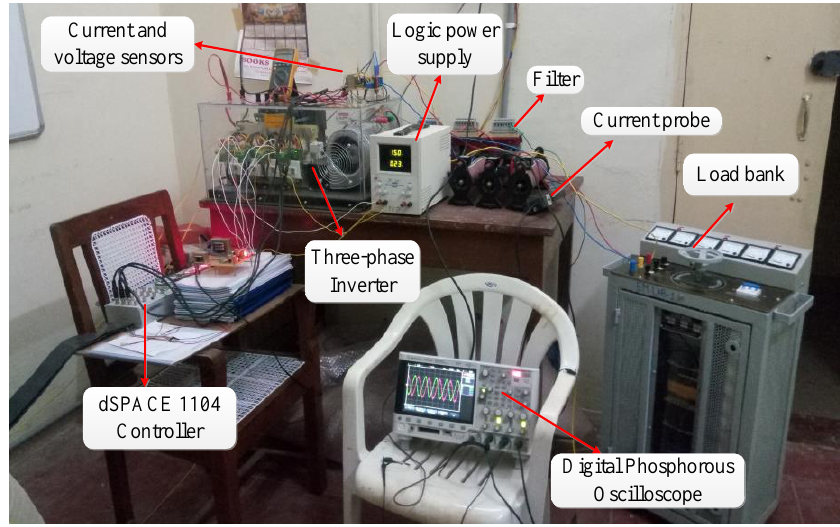
Figure 13. Experimental test rig.